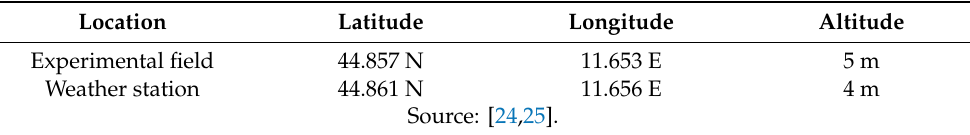
Table 2. Geospatial coordinates of experimental field and weather station of reference. Location Latitude Longitude Altitude Experimental field 44.857 N Weather